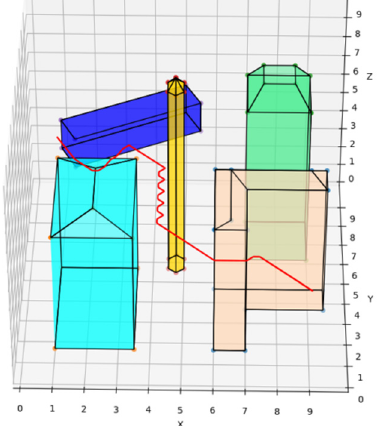
Figure 17. UAV route with light load and heavy disturbance.